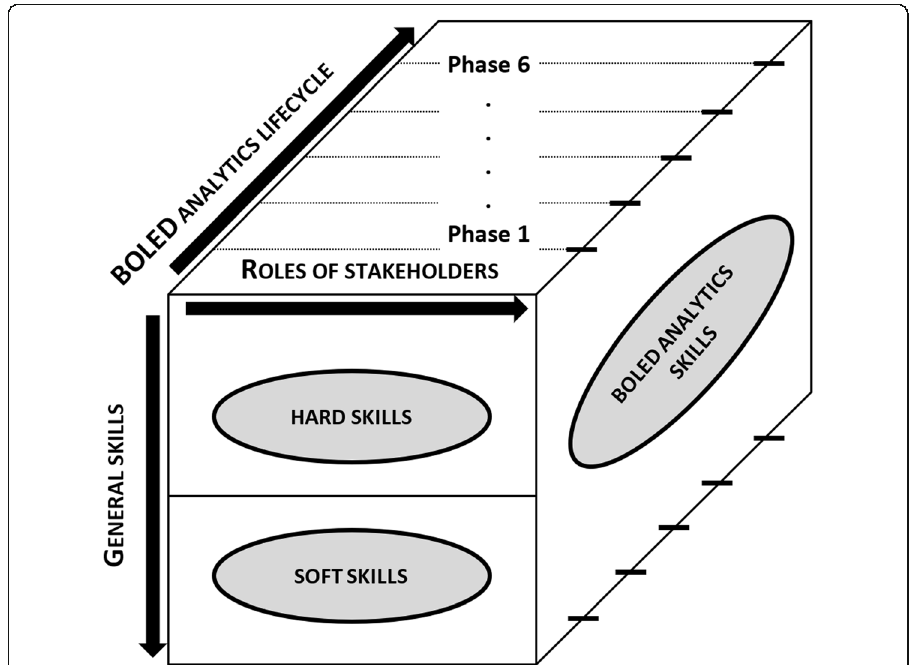
Fig. 7 A three-dimensional representation of required skills in the framework